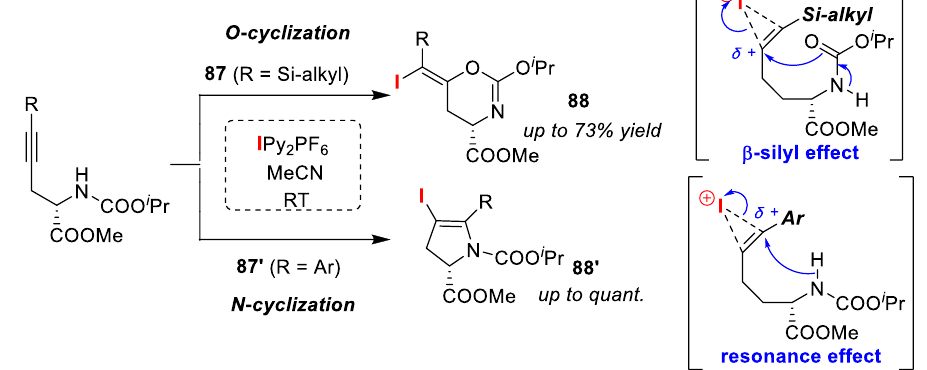
Figure 41. Selective syntheses of oxazines 88 and 2,3-dihydropyrroles 8 8′ via iodo-cyclizations of alkylamides ( 87 and 8 7′ ) using IPy 2 PF 6 .